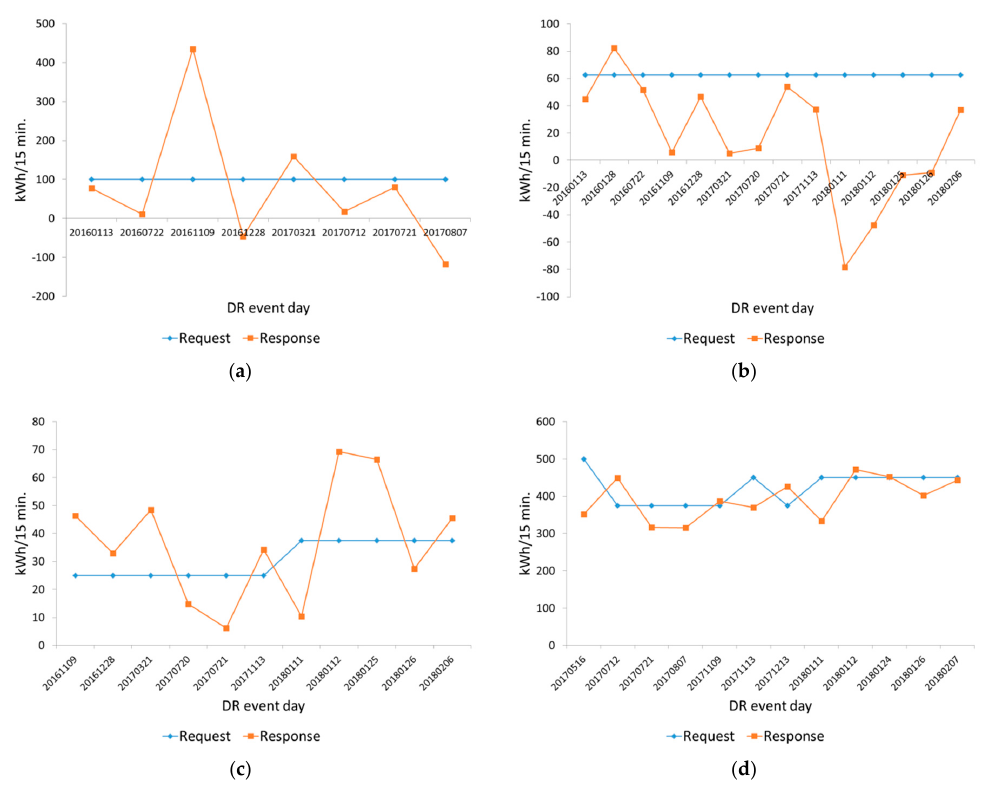
Figure 5. The amount of load reduction from several customers. ( a ) Customer #1; ( b ) Customer #2; ( c ) Customer #3; ( d ) Customer #4.